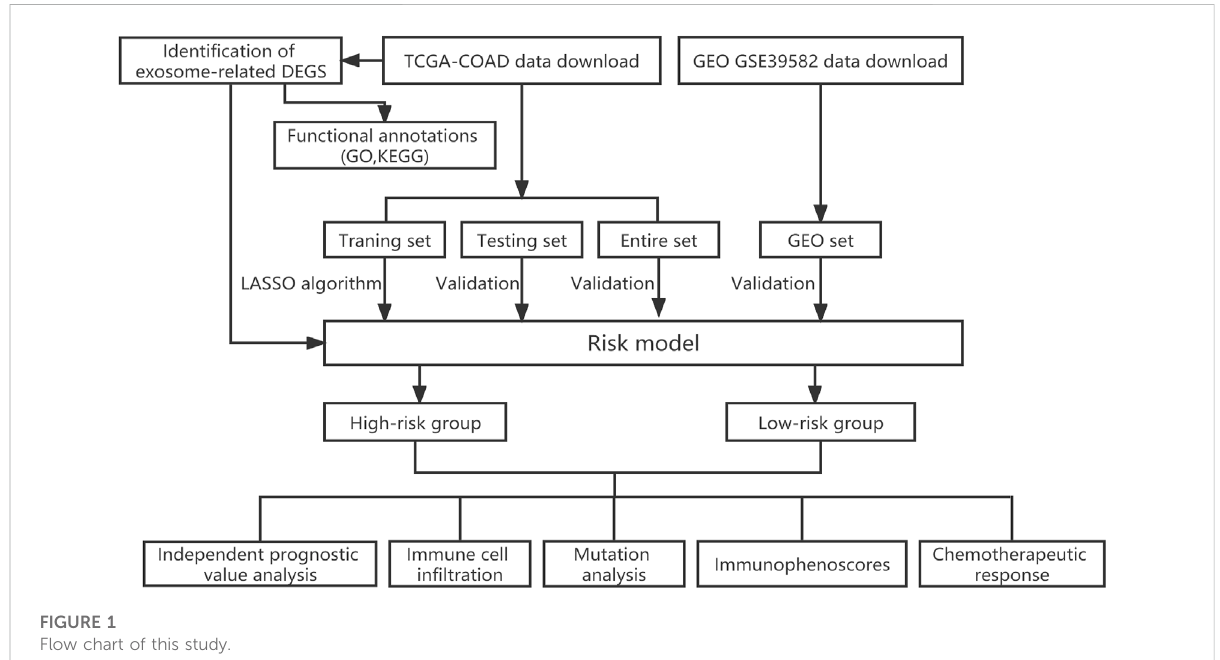
FIGURE 1 Flow chart of this study.